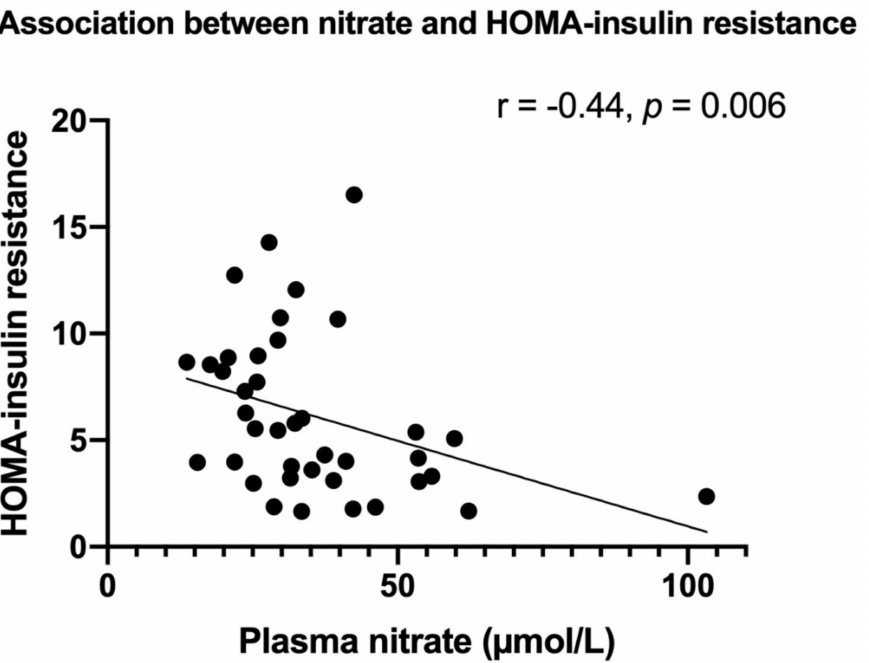
Figure 1. Nitrate plasma level was inversely related to HOMA-insulin resistance. Correlation between plasma nitrate concentration (as measured by high-performance liquid chromatography and expressed in µ mol/L) and HOMA-insulin resistance (HOMA-IR, fasting insulin * fasting glu- cose/22.5).